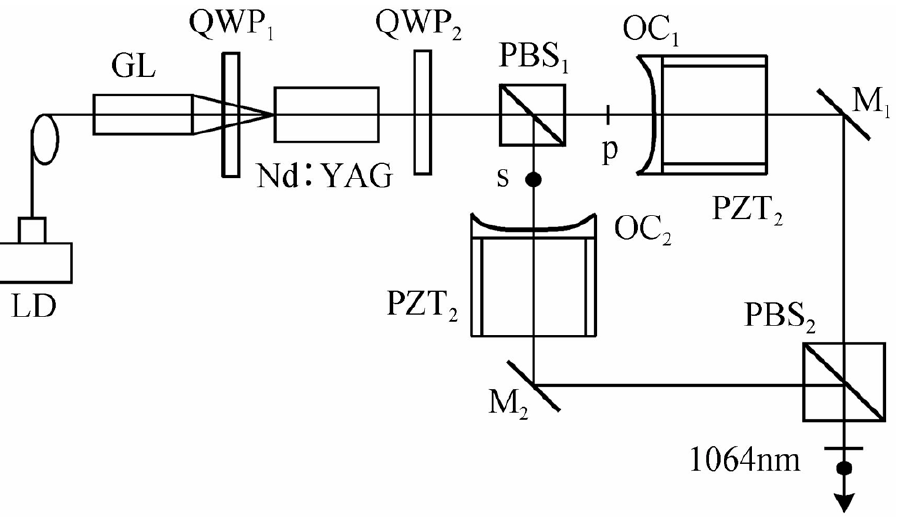
Figure 33. Schematic diagram of diode-pumped TCDFL using the twisted-mode configuration [38]. LD: laser diode; GL: gradient-index lens; QWP: quarter-wave plate; PBS: polarizing beam splitter; OC: output coupler; PZT: piezoelectric transducer; M: mirror.